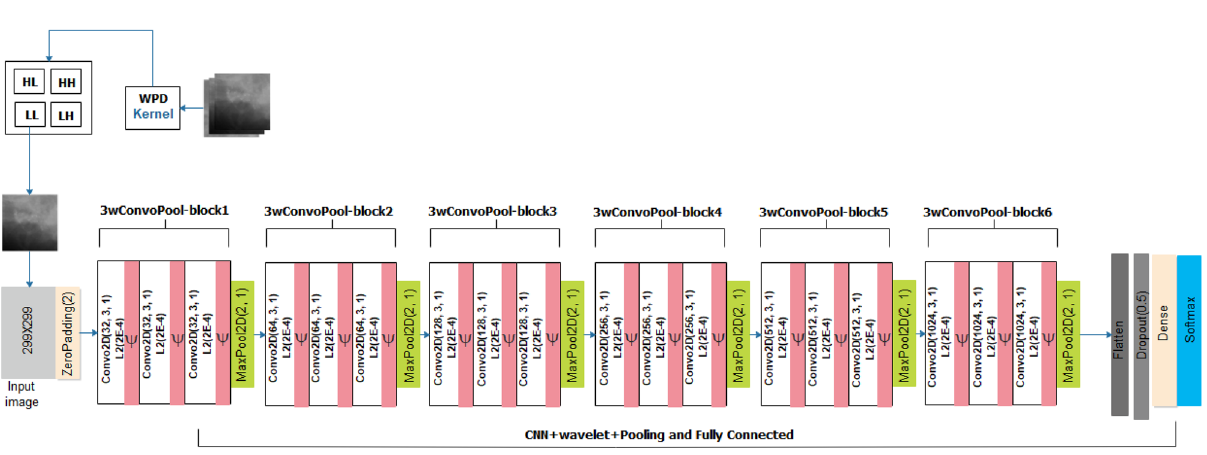
Figure 4. The architecture of the proposed CNN model for characterization of abnormalities in breast images.